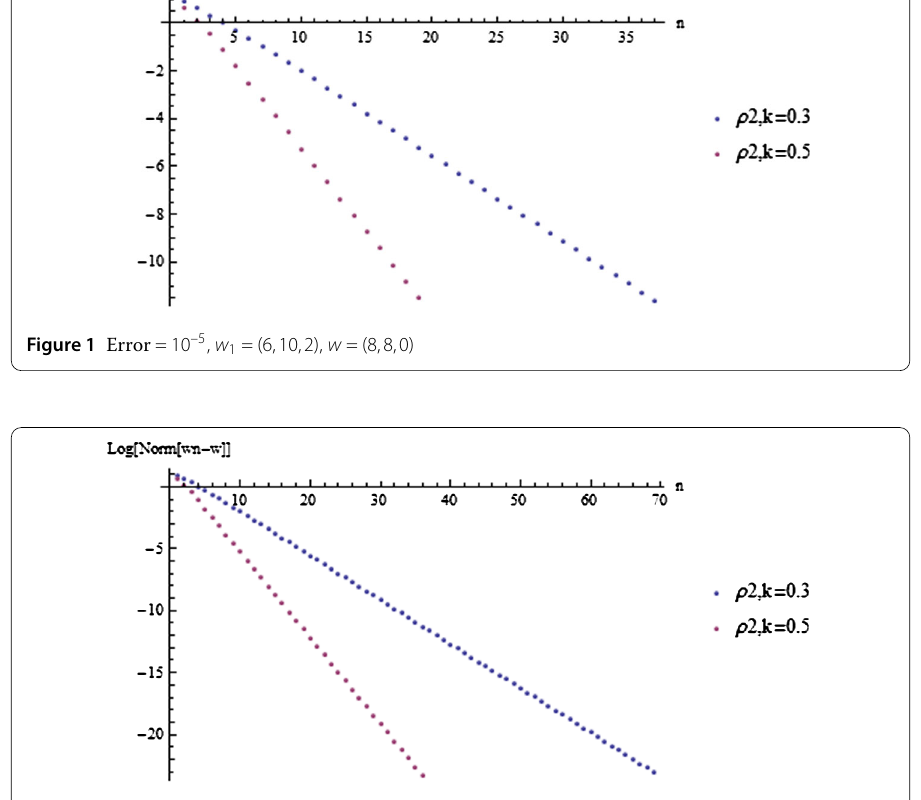
Figure 2 Error = 10 –10 , w 1 = (6,10,2), w =